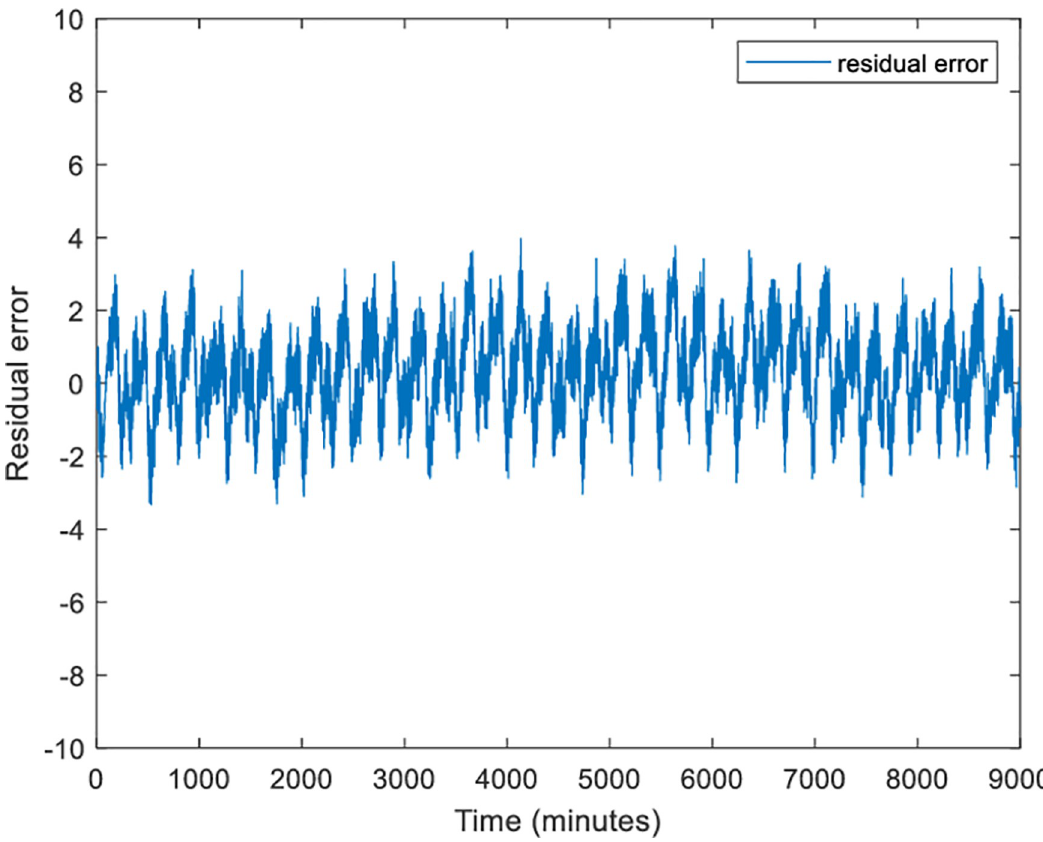
Fig 8. The residual error between the actual and simulated current.